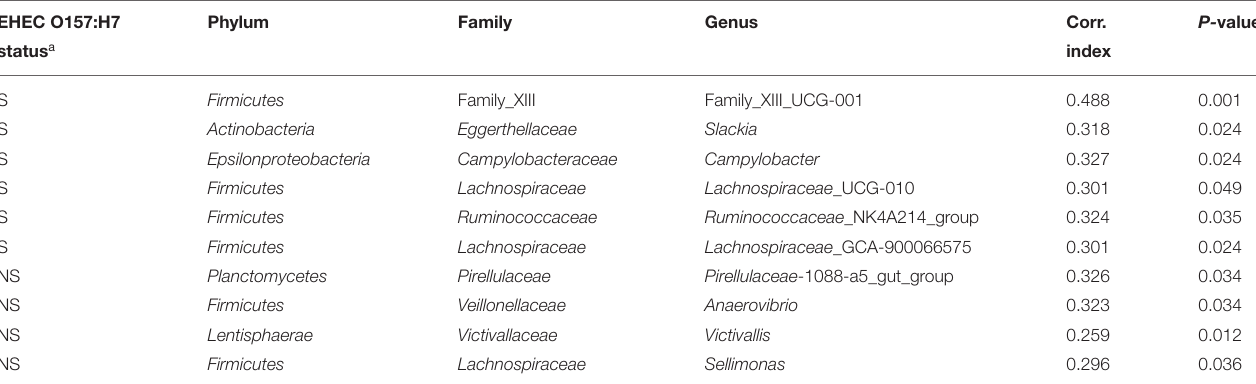
TABLE 4 | Indicator species analysis comparing EHEC O157:H7 shedder (S) and non-shedder (NS) groups. EHEC